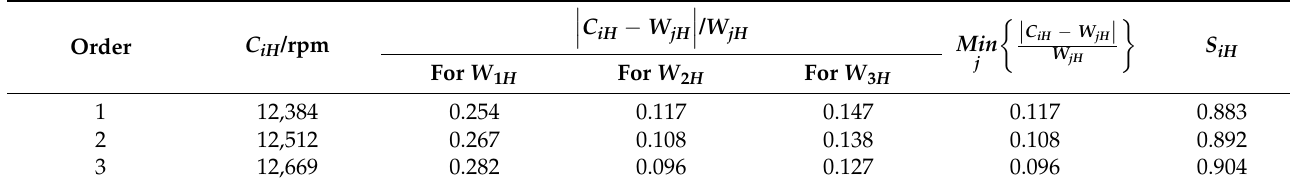
Table 5. Critical speed risk coefficients of the high-pressure